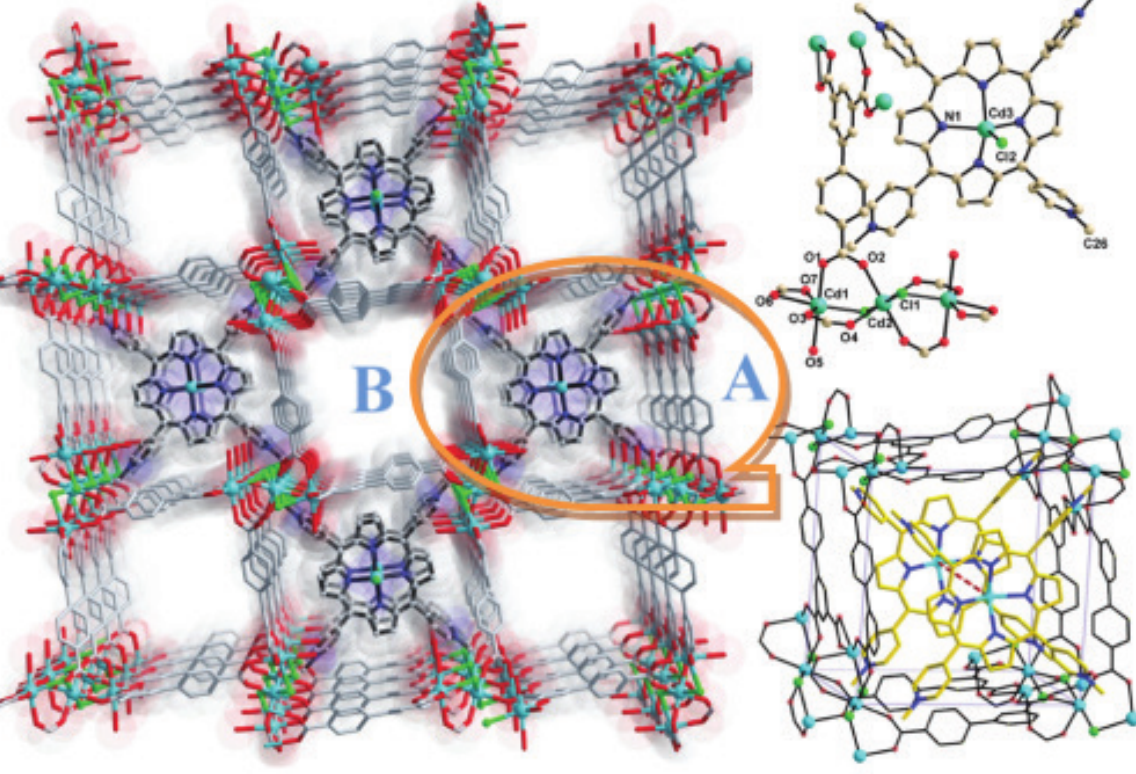
Figure 12: Projection of the structure of porph@MOF-10 along the c axis showing Cd(II)TMPyP in channel B (orange circle); (upper right) Components of the framework and Cd(II)TMPyP cations in porph@MOF-10; (lower right) Illustration of Cd(II)TMPyP cations trapped in square channels of porph@MOF-10 [113]. Reprinted with permission from Ref. [113]. Copyright © 2012, American Chemical